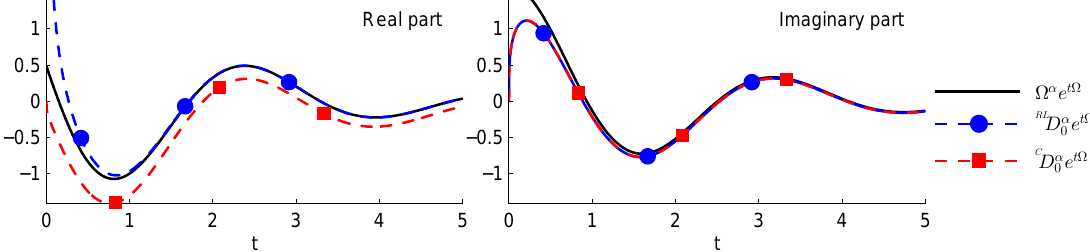
Figure 3. Comparison of RL D α